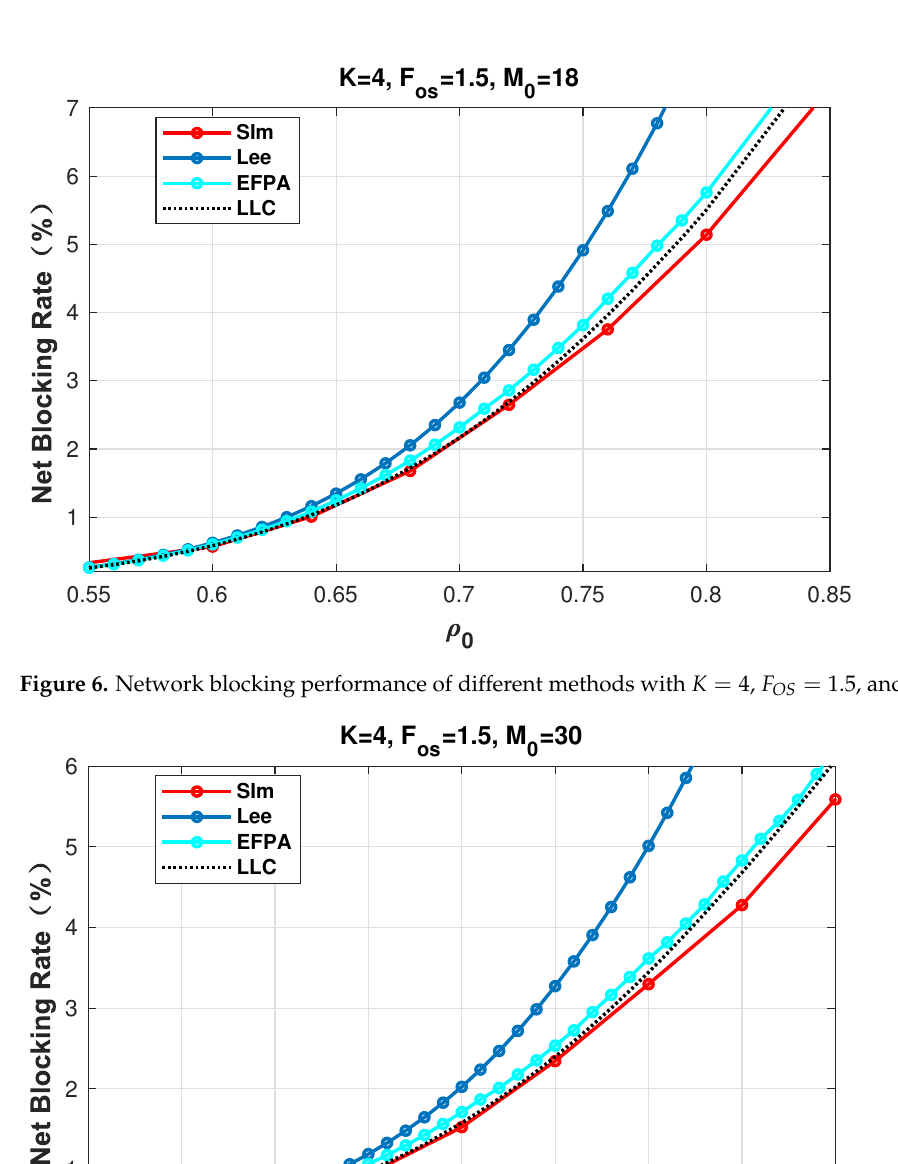
1%. For higher blocking rates, the curves of the LLC-based method and EFPA method gradually